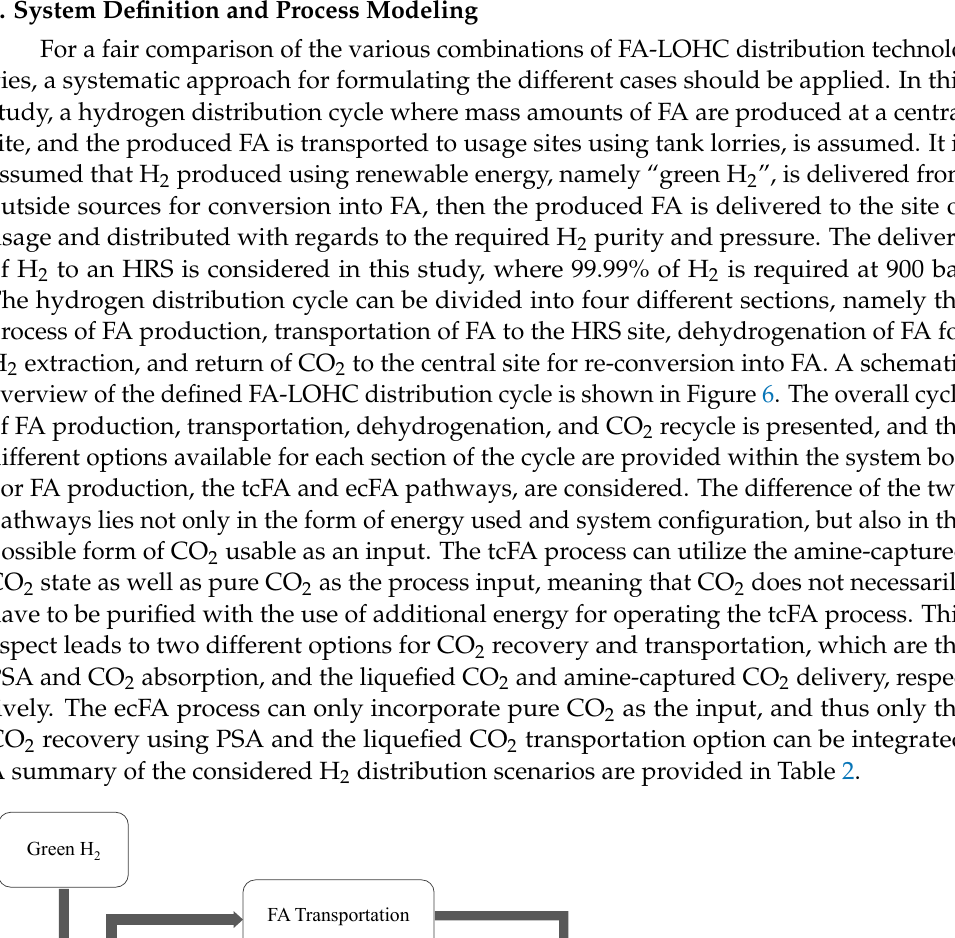
FA Dehydrogenation & CO 2